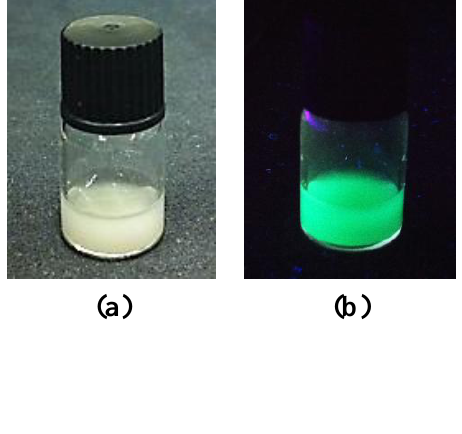
SiO :Eu 2+ nanoparticles under day ( a ) and UV light ( b 2 4